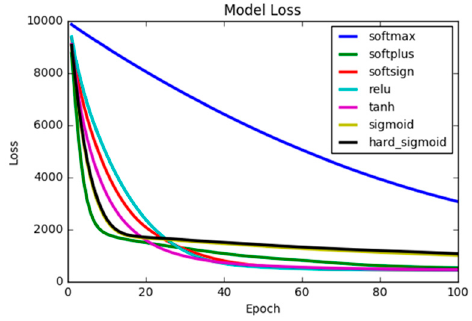
Figure 8. Comparison of training result in different activation function